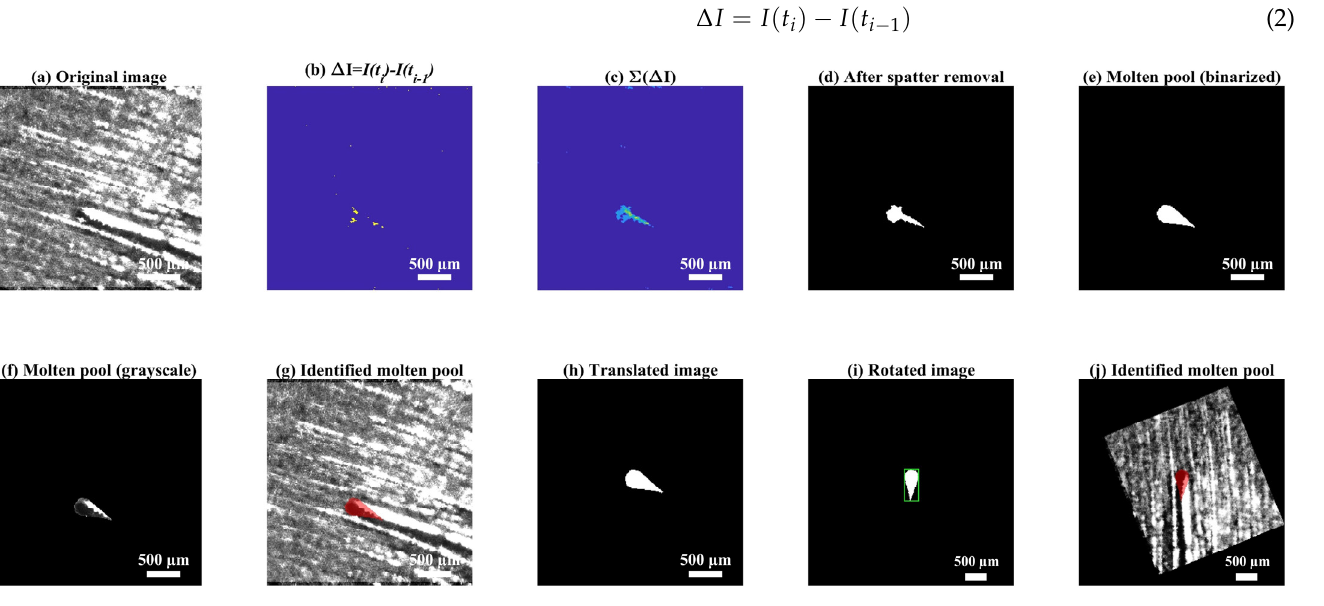
Figure 3. Different steps of the image processing algorithm developed to extract the oscillation indicator and the geometrical features of the melt pool. ( a ) Original frame; ( b ) difference between successive frames; ( c ) sum of the difference of different frames; ( d ) spatter removal via image erosion; ( e ) reconstructed molten pool in binarized frame; ( f ) with grayscale values. ( g ) Identified molten pool in red over original frame; ( h ) translation; ( i ) rotation of the molten pool to extract geometrical parameters such as width and length; and ( j ) translated and rotated image over the original